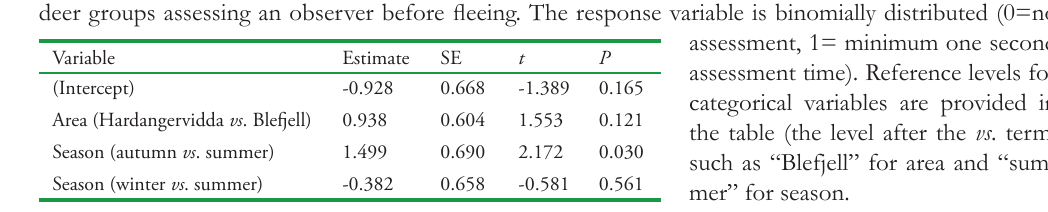
assessment, 1= minimum one second assessment time). Reference levels for categorical variables are provided in the table (the level after the vs . term, such as “Blefjell” for area and “sum- mer” for season. Table 7. Genetic variation in 14 microsatellites in reindeer from Blefjell together with reference val- ues of wild and semi-domestic reindeer herds from southern Norway. Values are number of individu- als analysed (n), mean number of alleles per locus (A), mean allele richness (Ar) per locus, and mean genetic diversity